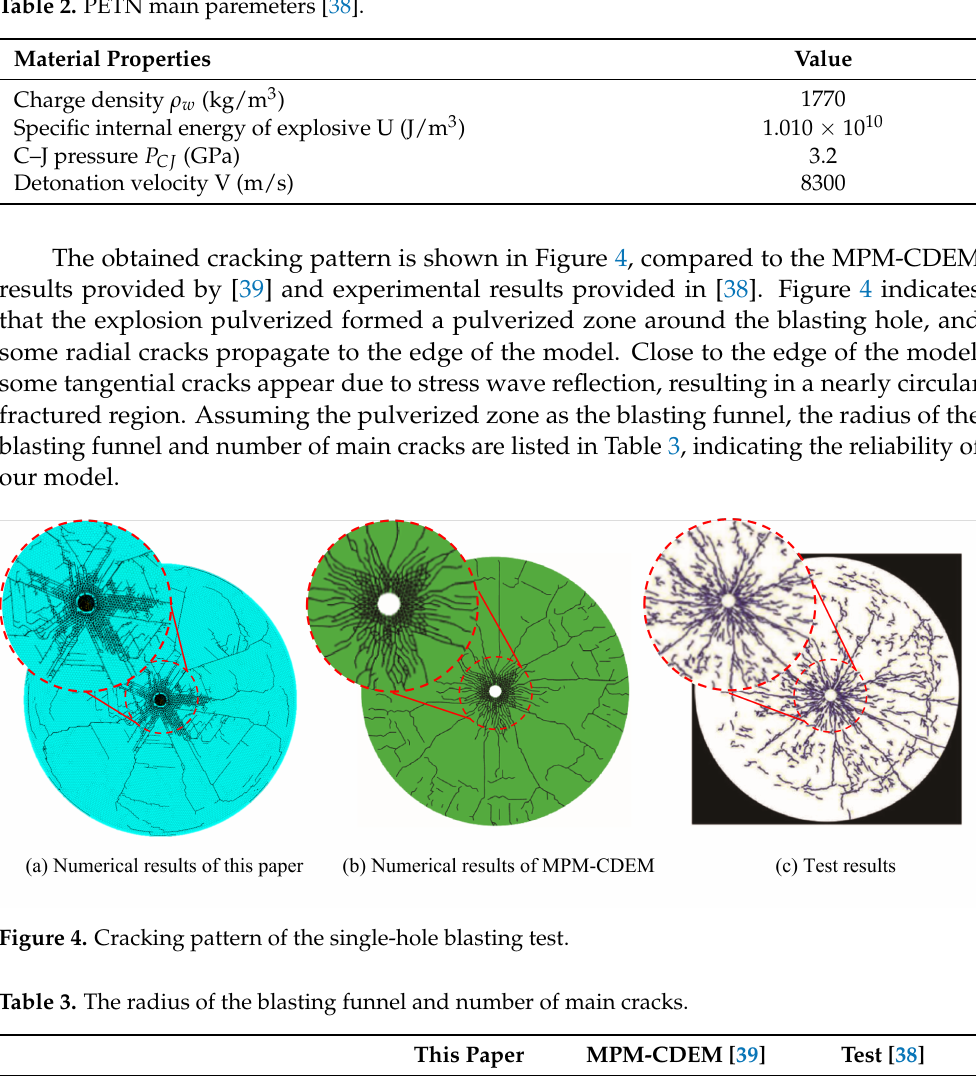
Table 2. PETN main paremeters [38].